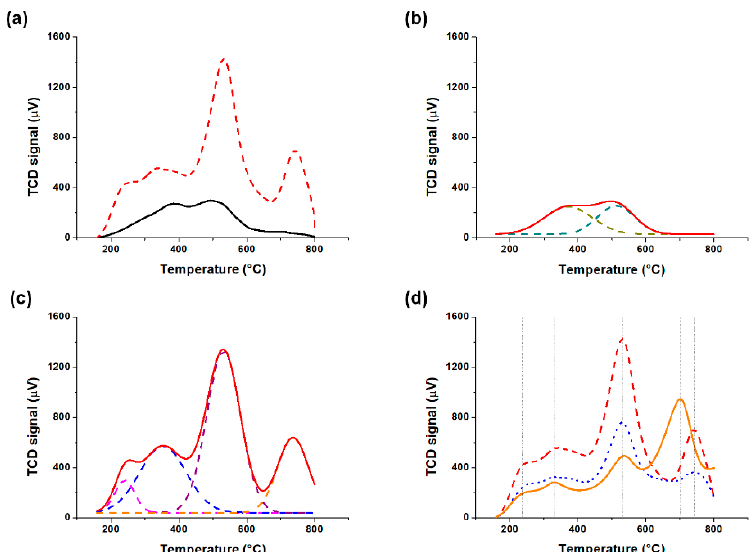
Figure 3. ( a ) Temperature programmed desorption of ammonia (NH 3 –TPD) profiles of intact SnO 2 (black line) and SO 42 − /SnO 2 (red dashed line); ( b – c ) Deconvolution of overlapped peaks in the profiles. The samples were prepared by calcination at 550 °C for 4 h; ( d ) NH 3 –TPD profiles of SO 42 − /SnO 2 calcined at 550 °C (red dashed line), 600 °C (blue dotted line), and 650 °C (orange line). Table 1. NH 3 uptake of intact SnO 2 and SO 42 − /SnO 2 calcined at different temperatures.